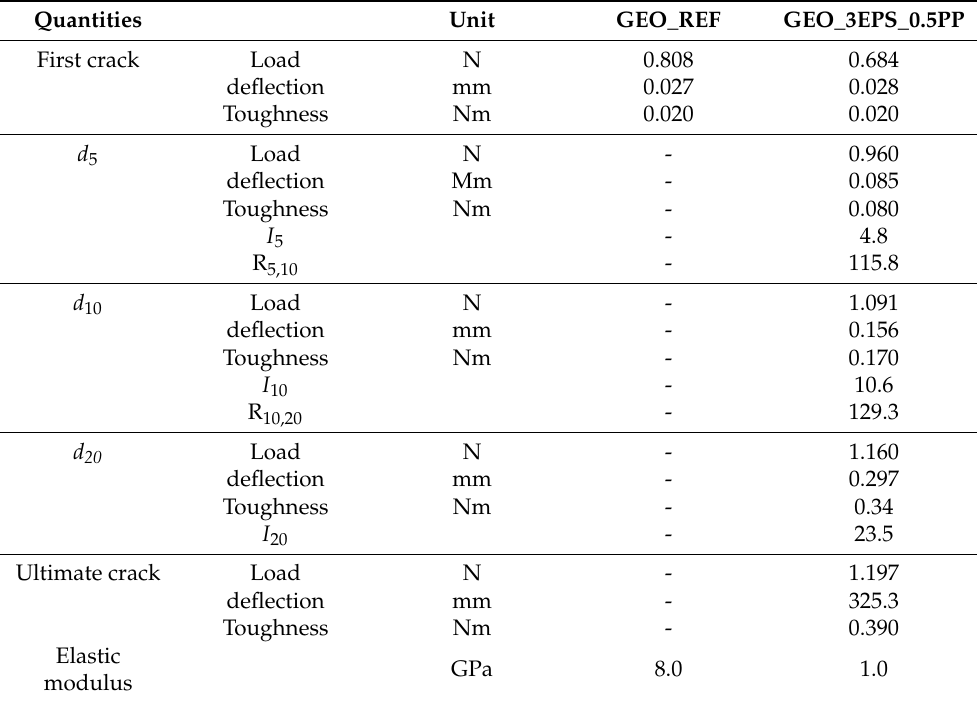
Table 4. Average response quantities for flexural